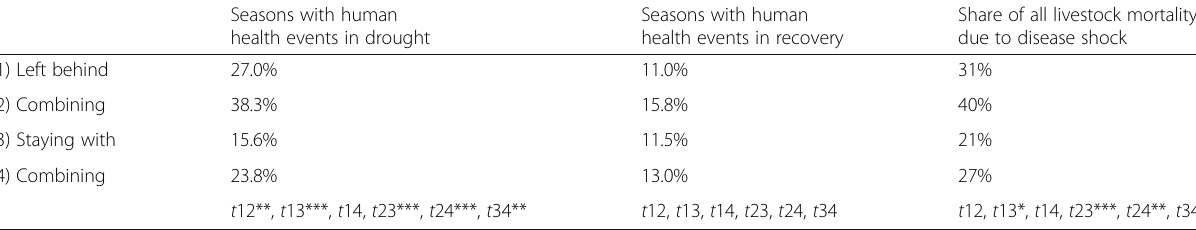
Table 8 Human and animal disease incidence